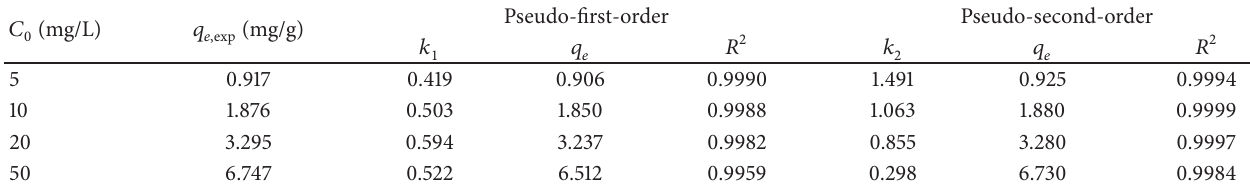
Table 3: Kinetic parameters for the adsorption of Cu(II) onto AWS at different initial concentrations. 𝐶 0 (mg/L)